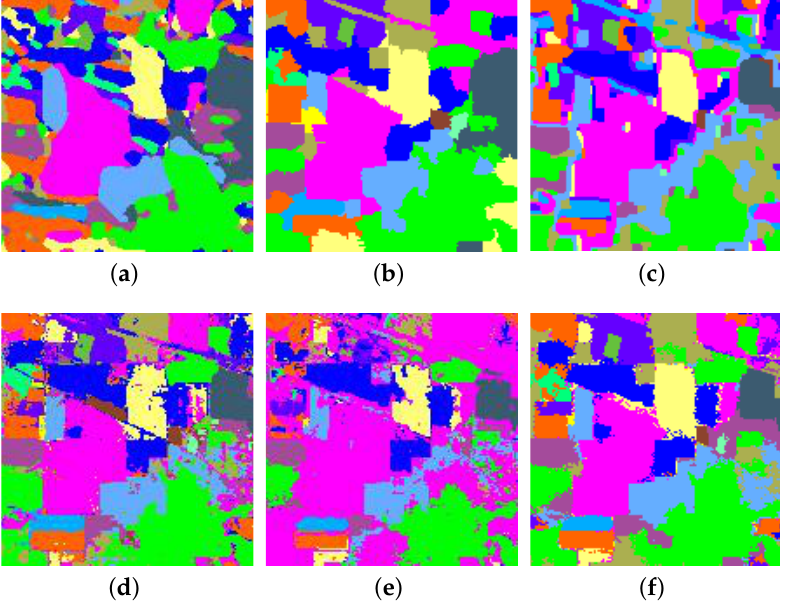
Figure 10. Classification maps for the Indian Pines data set using different methods. ( a ) HybridSN; ( b ) STSE_DWLR; ( c ) CNN-MRF; ( d ) LCMR; ( e ) RPNet; ( f ) SANet.